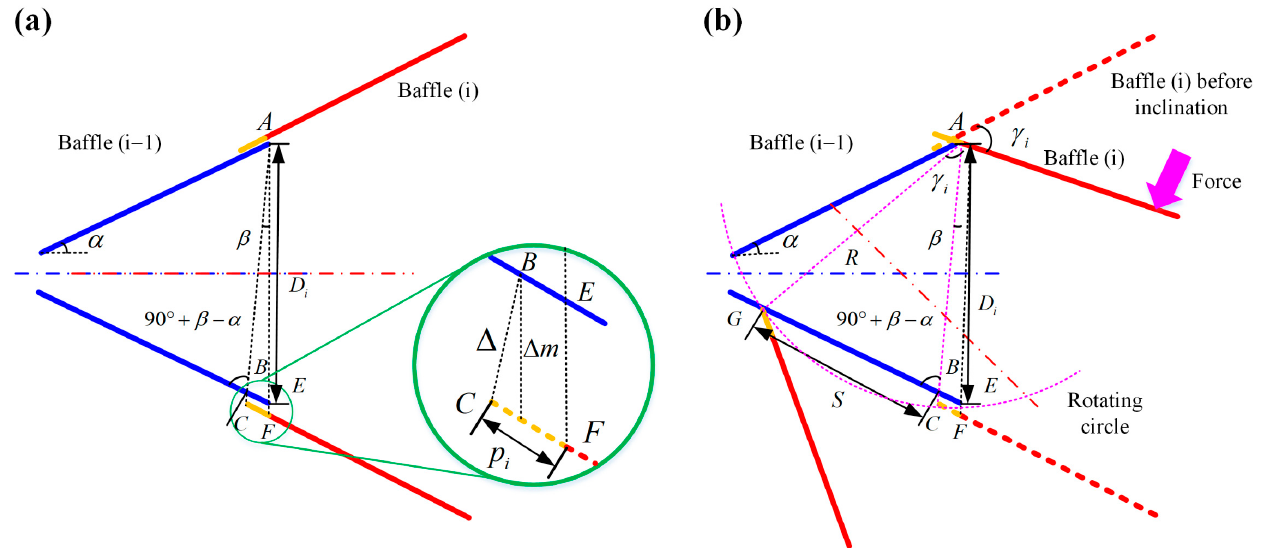
Figure 10. ( a ) The adjacent sub-baffles are deployed without external force. ( b ) The relative inclination model between sub-baffles for deployable baffle.